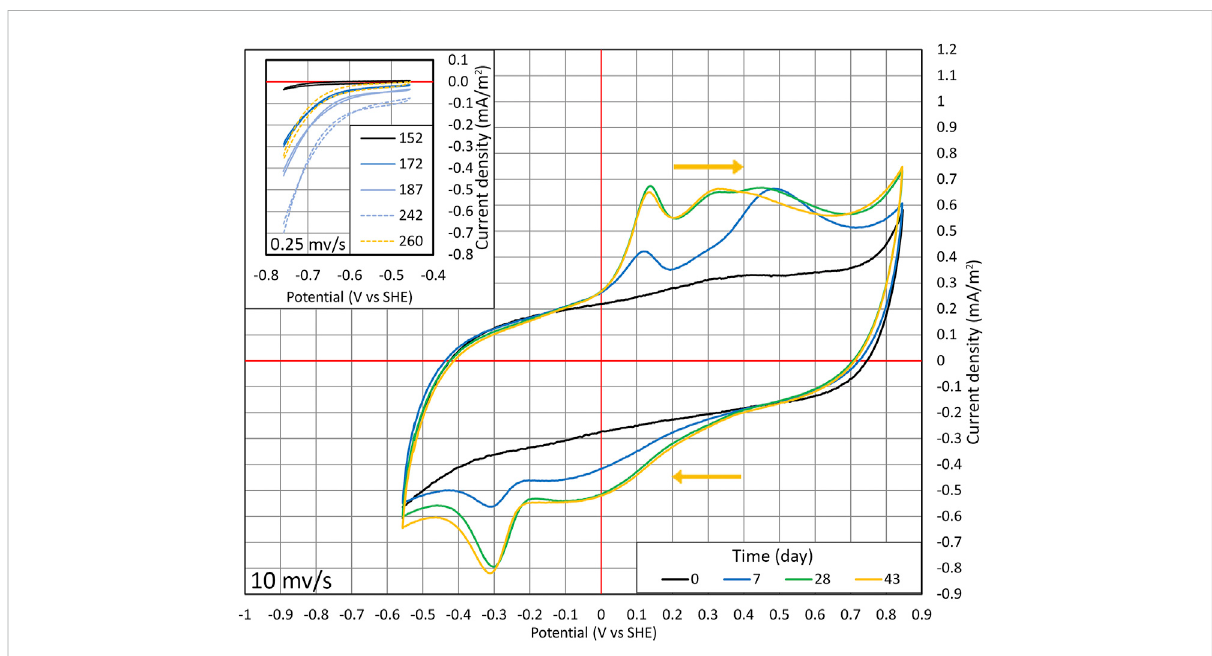
Cyclic voltammetry conducted during cycles (1:1) and (1:2). From days 0 to 43, CV was performed in the range of − 556 to +846 mV at the potential sweep rate of 10 mV/s. Time points when the wide range of measurements was conducted are shown with the red dots in Figure 2B. The inset section shows the situation where CV is performed in the range of − 756 to − 456 mV at the potential sweep rate of 0.25 mV/s on days from 152 to 260, and the time points are shown in Figure 2B with the blue